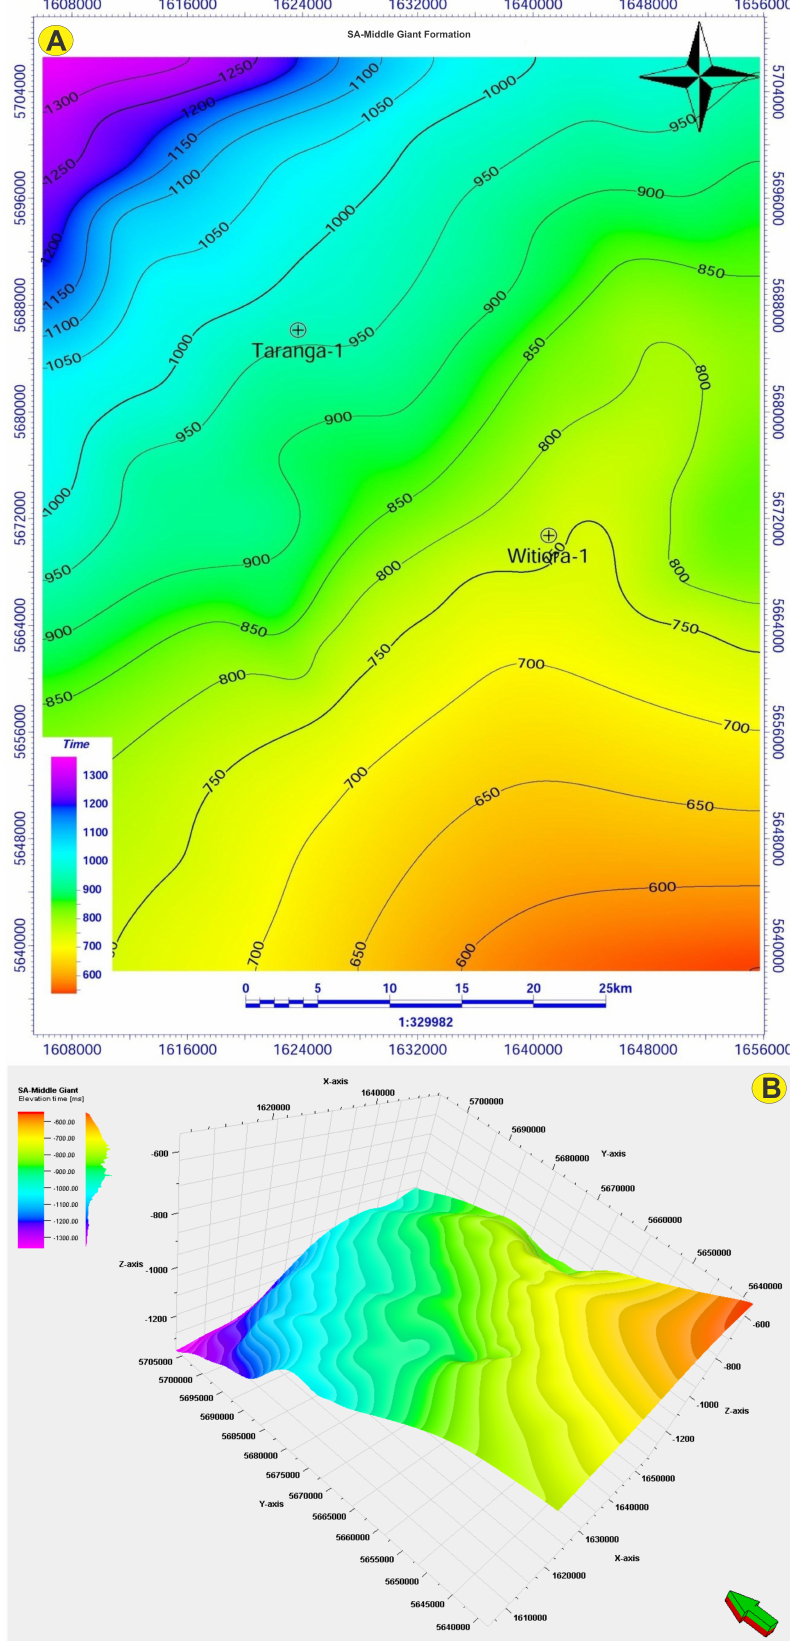
Figure 12. A-shows the A) 2D isochron map of SA-Middle Giant Formation, B- shows the 3D isochron map of SA-Middle Giant